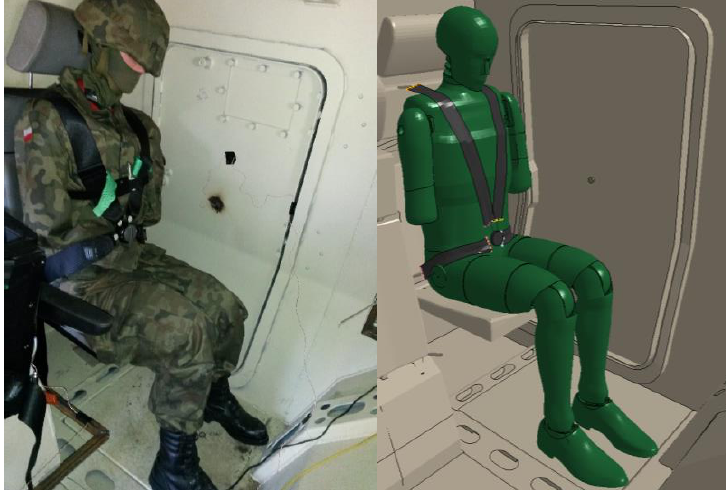
Figure 8. The view of the EuroSID-2re dummy during the experimental tests and in the numerical model Measurement results obtained from the experimental tests and numerical calculations are